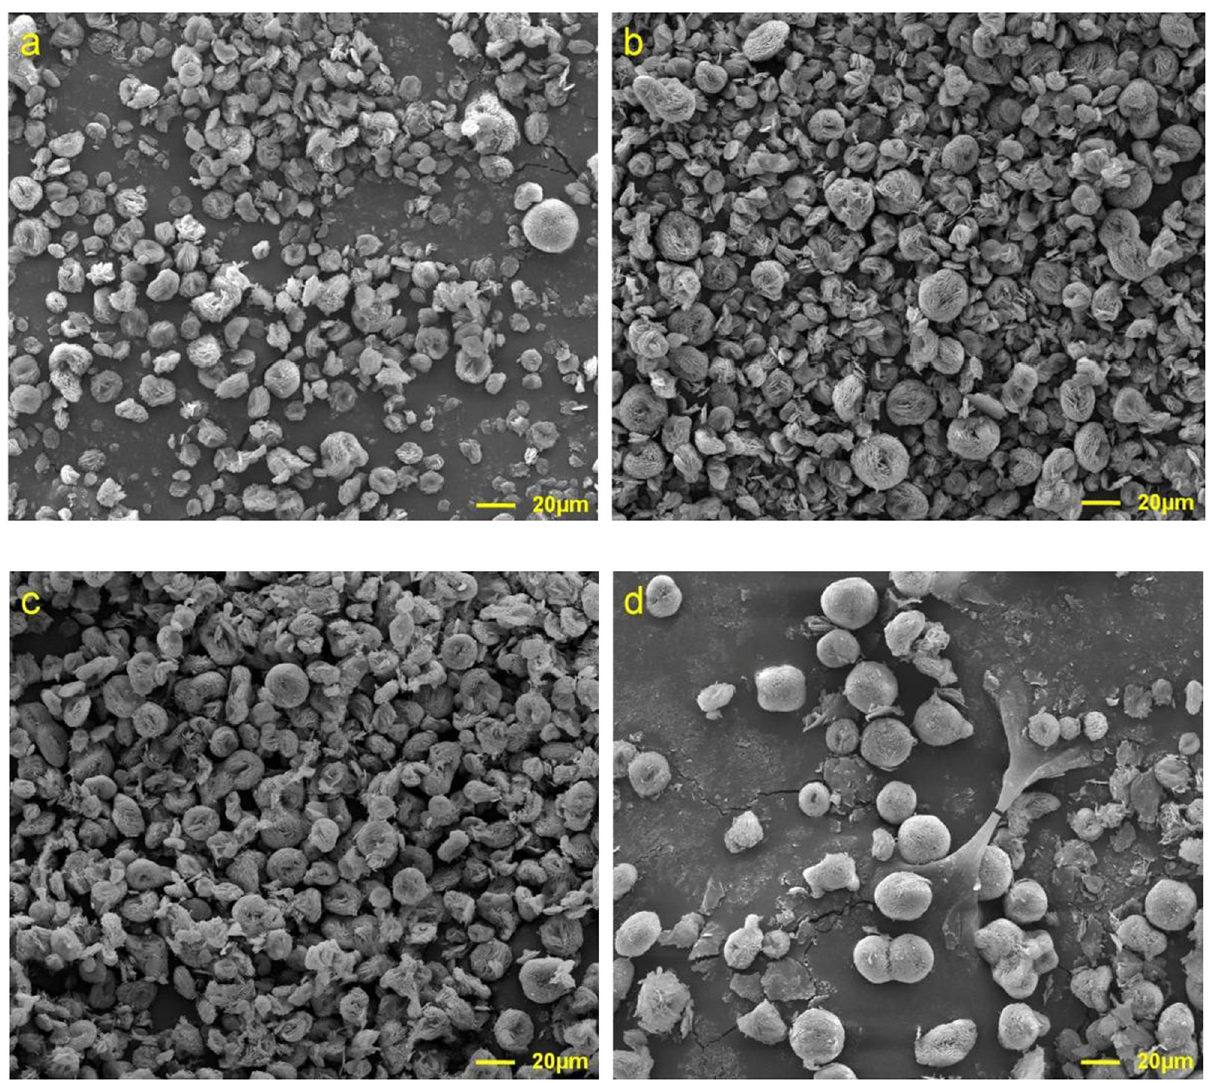
Figure 5: SEM images for the carbonation products from di ff erent aging times: ( a ) 1 h, ( b ) 4 h, ( c ) 8 h, and ( d ) 12